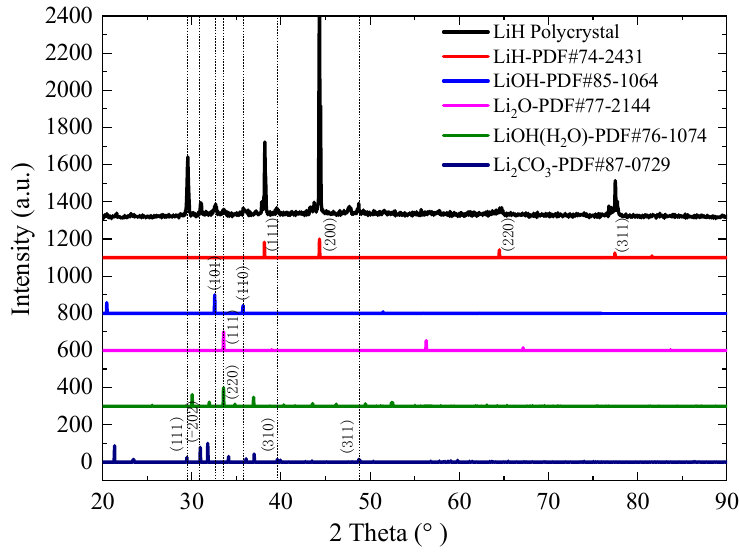
Figure 14. XRD pattern of polycrystalline LiH. Figure 14. XRD pa(cid:308)ern of polycrystalline LiH.